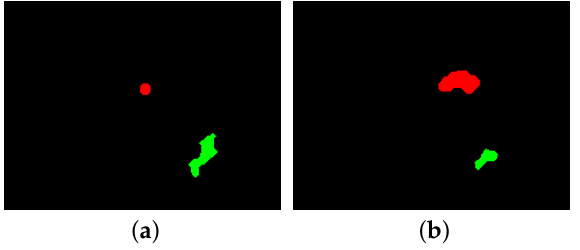
Figure 6. Green sections demonstrate positive-polarity areas and red regions represent negative-polarity areas. ( a ) incident is classified as slip; ( b ) incident is classified as vibration.